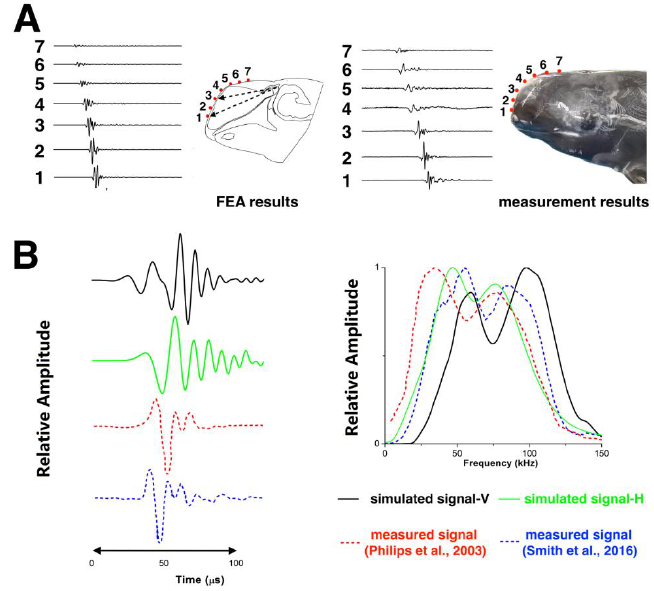
Figure 4. Comparison of the simulated FEA results with recordings from live, echolocating Risso’s dolphins. ( A ) Acoustic field at seven receiver points on the dolphin’s forehead: FEA results ( left ) vs. live measurements ( right ). Amplitudes of all waveforms scaled relative to the highest amplitude. ( B ) Comparison of the simulated and measured [2,4] far-field waveforms ( left ) and spectra ( right ); V: vertical model; H: horizontal model.